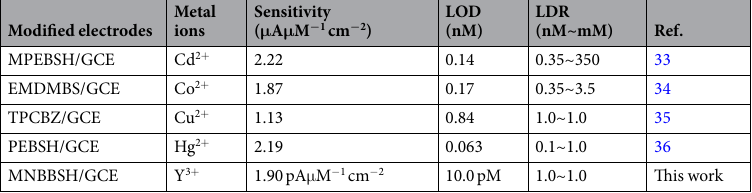
Table 3. Detection of various metal ions using I–V technique.